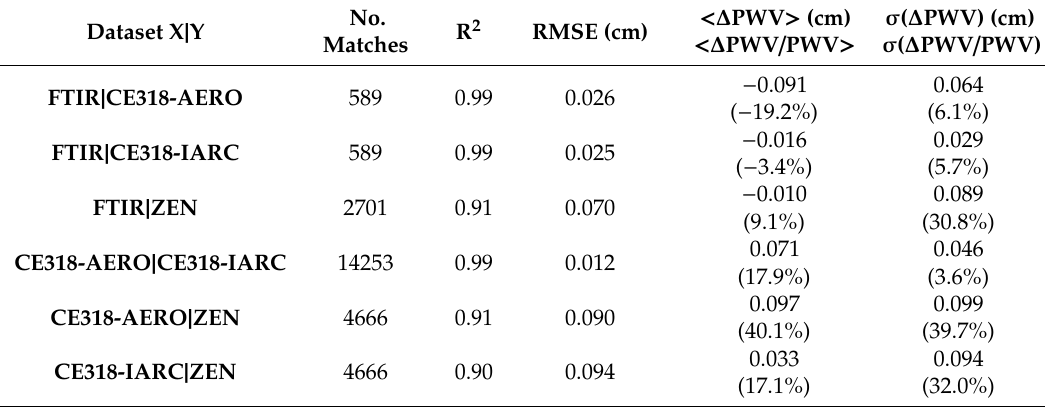
Figure 9. PWV scatterplots between ZEN-R52, CE318-AERONET, CE318-IARC and FTIR at Izaña over a 10-month period (August 2017 to June 2018 a – f ). The red line shows the linear fit equation, the broken grey line shows the diagonal and the colour bar indicates the density of data. Table 3. Comparisons statistics between PWV obtained from ZEN-R52, CE318-AERONET, CE318- Izaña Atmospheric Research Center (IARC) and FTIR. Mean and standard deviations of the PWV di ff erences, in cm (here represented as < ∆ PWV > and σ ( ∆ PWV)), are included, in addition to relative PWV di ff erences ( ∆ PWV / PWV) and the standard deviation of relative PWV di ff erences ( σ ( ∆ PWV / PWV)), in %, taking the X dataset as a